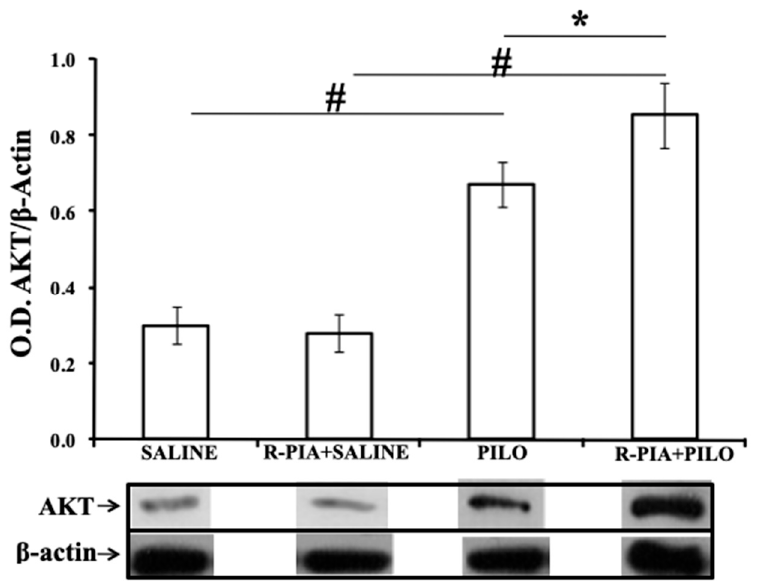
Figure 3. Expression of AKT (protein kinase B) in hippocampal samples of rats from SALINE, R-PIA+SALINE, PILO, and R-PIA+PILO groups. Bars represent the mean ± standard deviation of optical density for each group (N = 4/group), normalized to β -actin. (R-PIA+PILO vs. PILO, * t P = 0.05; R-PIA+PILO vs. R-PIA+SALINA, PILO vs SALINA, # p = 0.03; Kruskal–Wallis with Wilcoxon post hoc).